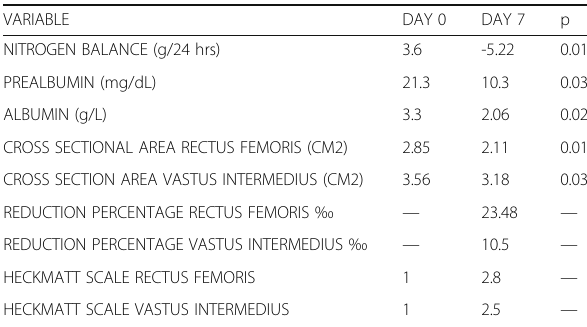
Table 2 (abstract 0220). Characteristics of Biochemical and Sonographic Measurements